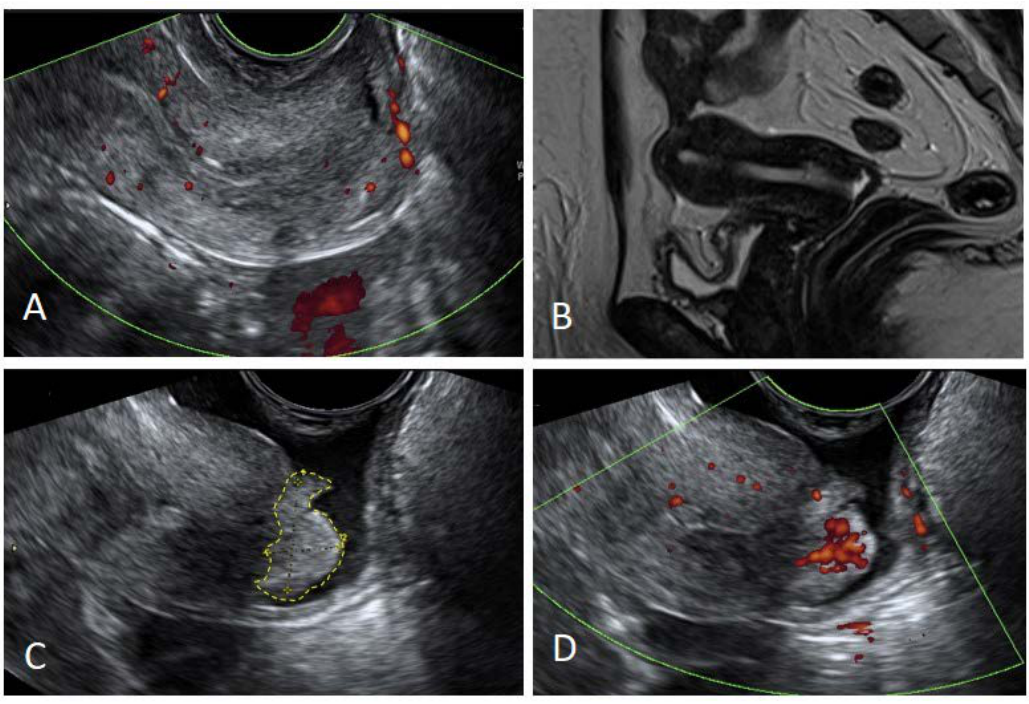
Figure 4. Detection of small tumors with VGS. ( A , B ) Small tumor not detectable at TVUS and MRI; ( C,D ) the same tumor detected by adding VGS and PD.